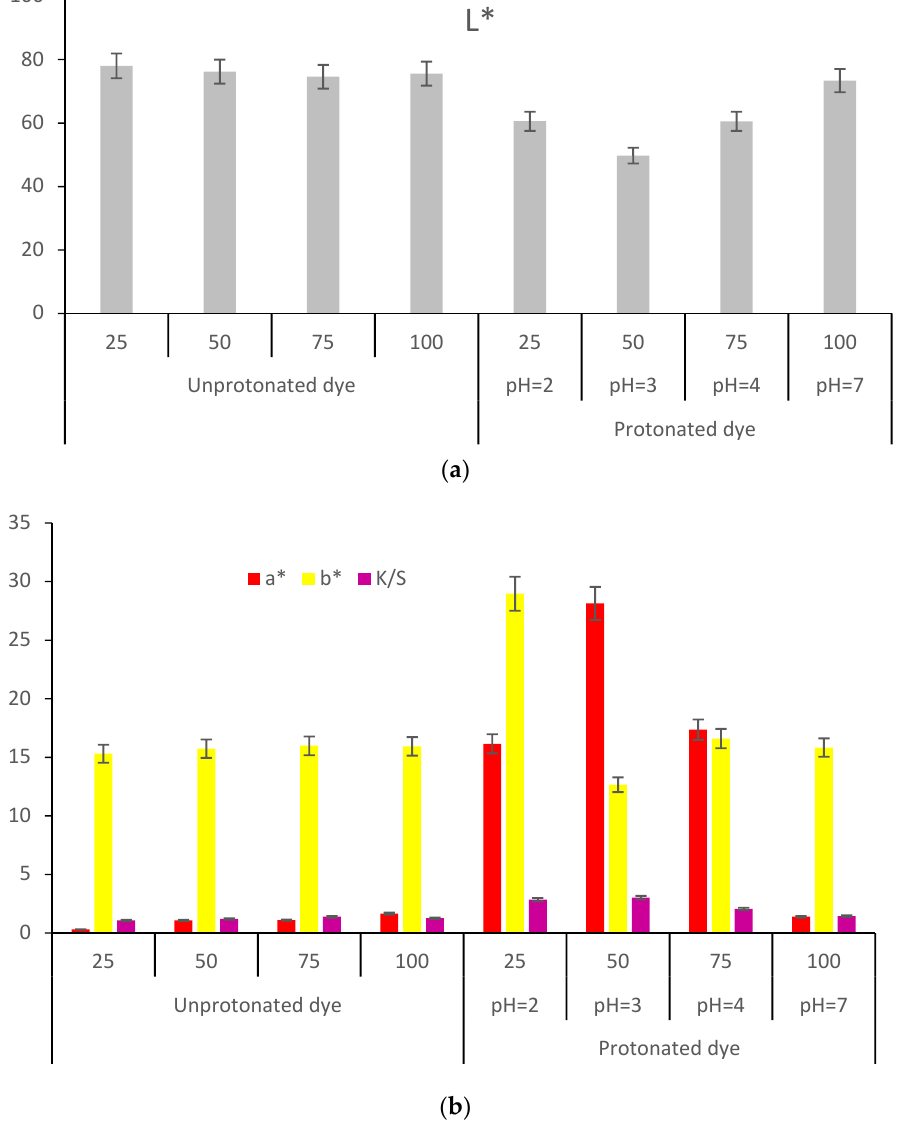
Figure 14. Influence of increasing the volume of colored extract (25–100 mL) on the color characteristics of wool samples dyed with non-protonated extract and with protonated extract at pH = 2–7: L* ( a ) and a*, b*, K/S ( b ); dyeing conditions: T = 40 °C, t = 2 h, liquid ratio M = 1:100. The use of 100 mL extracts with different pH values led to red colors characterized by lower lightness at lower pHs. Therefore, the higher color strengths and the strongest shades of red were obtained at low pH, which was due to the deprotonation of the extract (Figure 15).